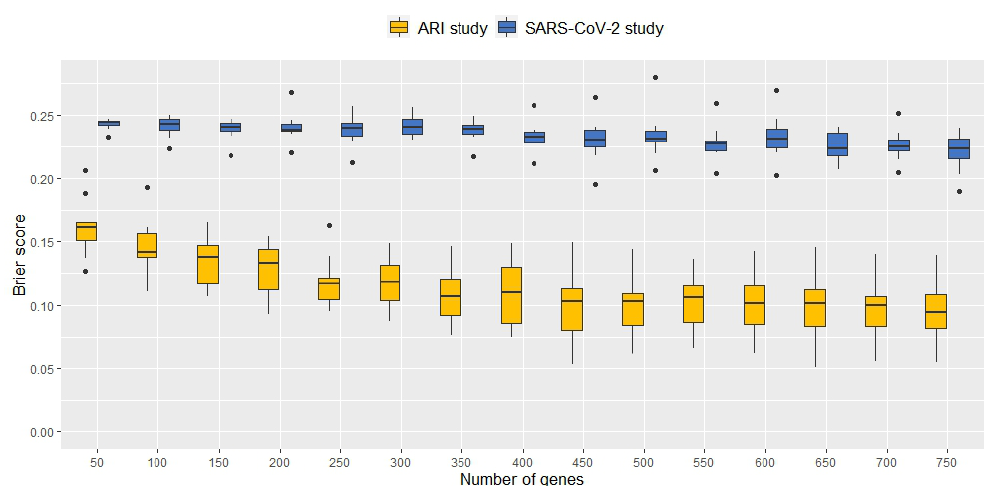
Figure 1. Brier scores from 10-fold cross-validation for the original microarray dataset (orange) and the original RNA-seq dataset (blue) when including an increasing number of top differentially expressed genes as input features for the ANN. The median Brier score tended to decrease when increasing the number of genes as predictors from 50 to